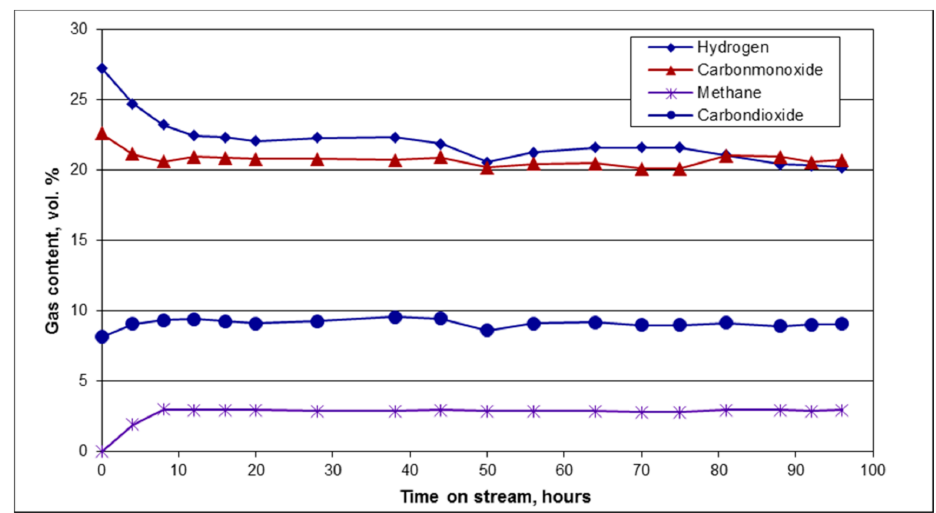
Figure 13. Gas composition variation with time on stream. Initial gas composition: H 2 (20%), CO (20%), CO 2 (9%), CH 4 (3%); (T—750 ◦ C, GHSV—12,800 h − 1 , S/C—5, catalyst—7.5% Ni- montmorillonite, naphthalene loading—12 g/m 3